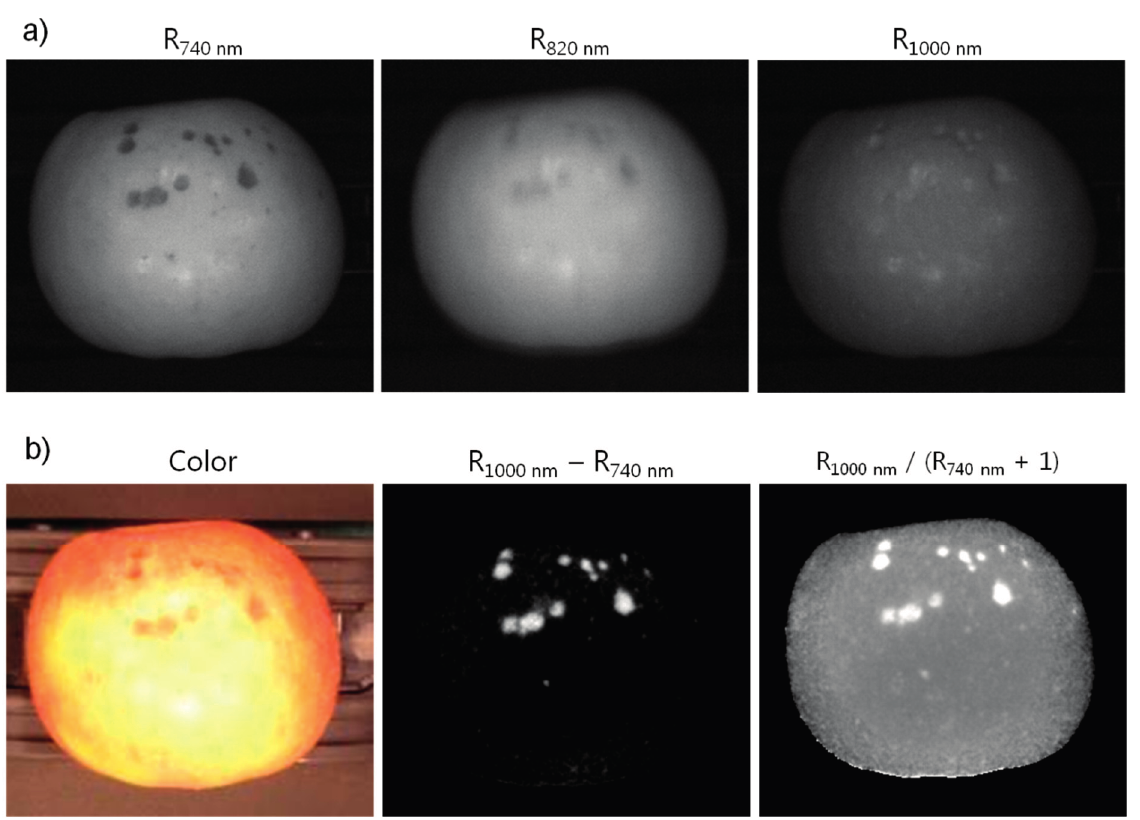
( b ) Color photo of the Fuji apple, two-band difference image, and two-band ratio